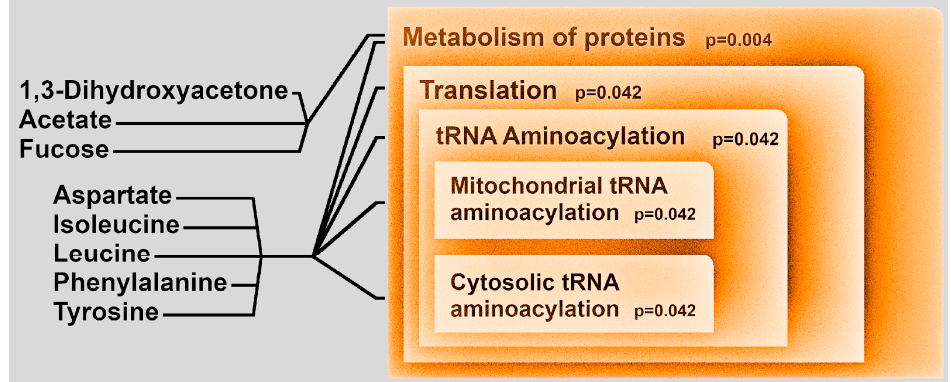
Figure 3. Metabolic pathways over-representation analysis based on the molecules significantly differed between low-ADOS and high-ADOS children. Orange and gray colors are used, respec- tively, for pathways significantly and insignificantly over-represented. Pathways are sub-leveled following Reactome’s hierarchy.